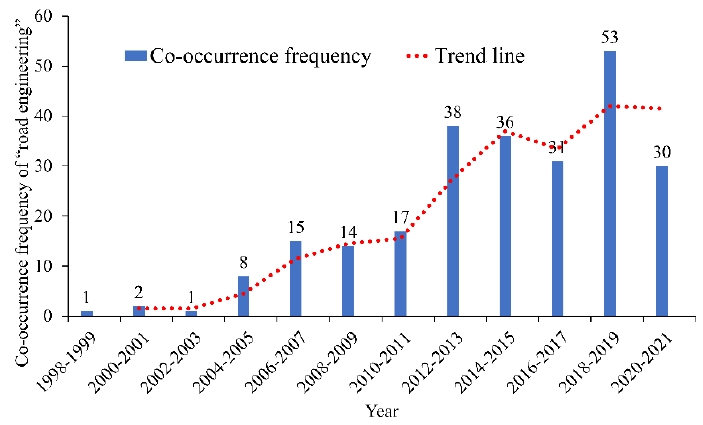
Figure 8. Co-occurrence frequency and time distribution of “road engineering”.